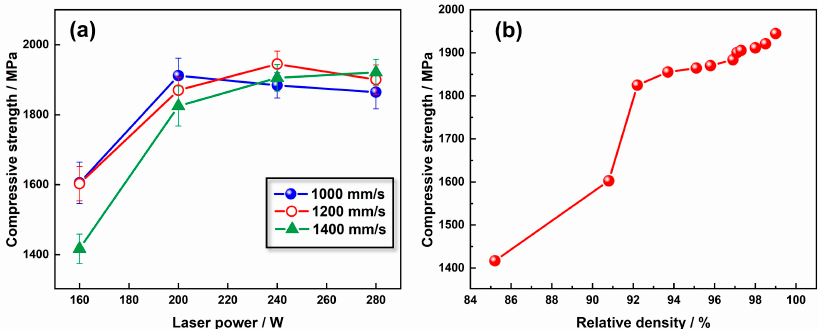
Figure 4. ( a ) Compressive strength of Ti6Al4V alloy and ( b ) the relationship between the compressive strength and the relative density.